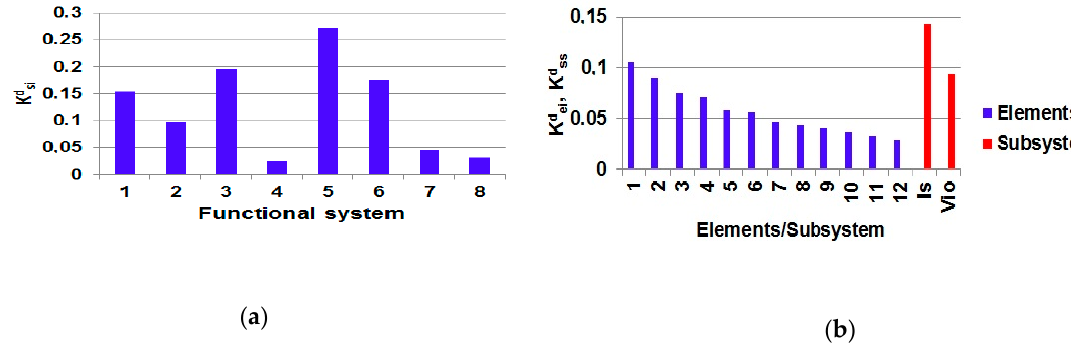
Figure 3. Diagram participation of individual damages of functional systems of marine engines